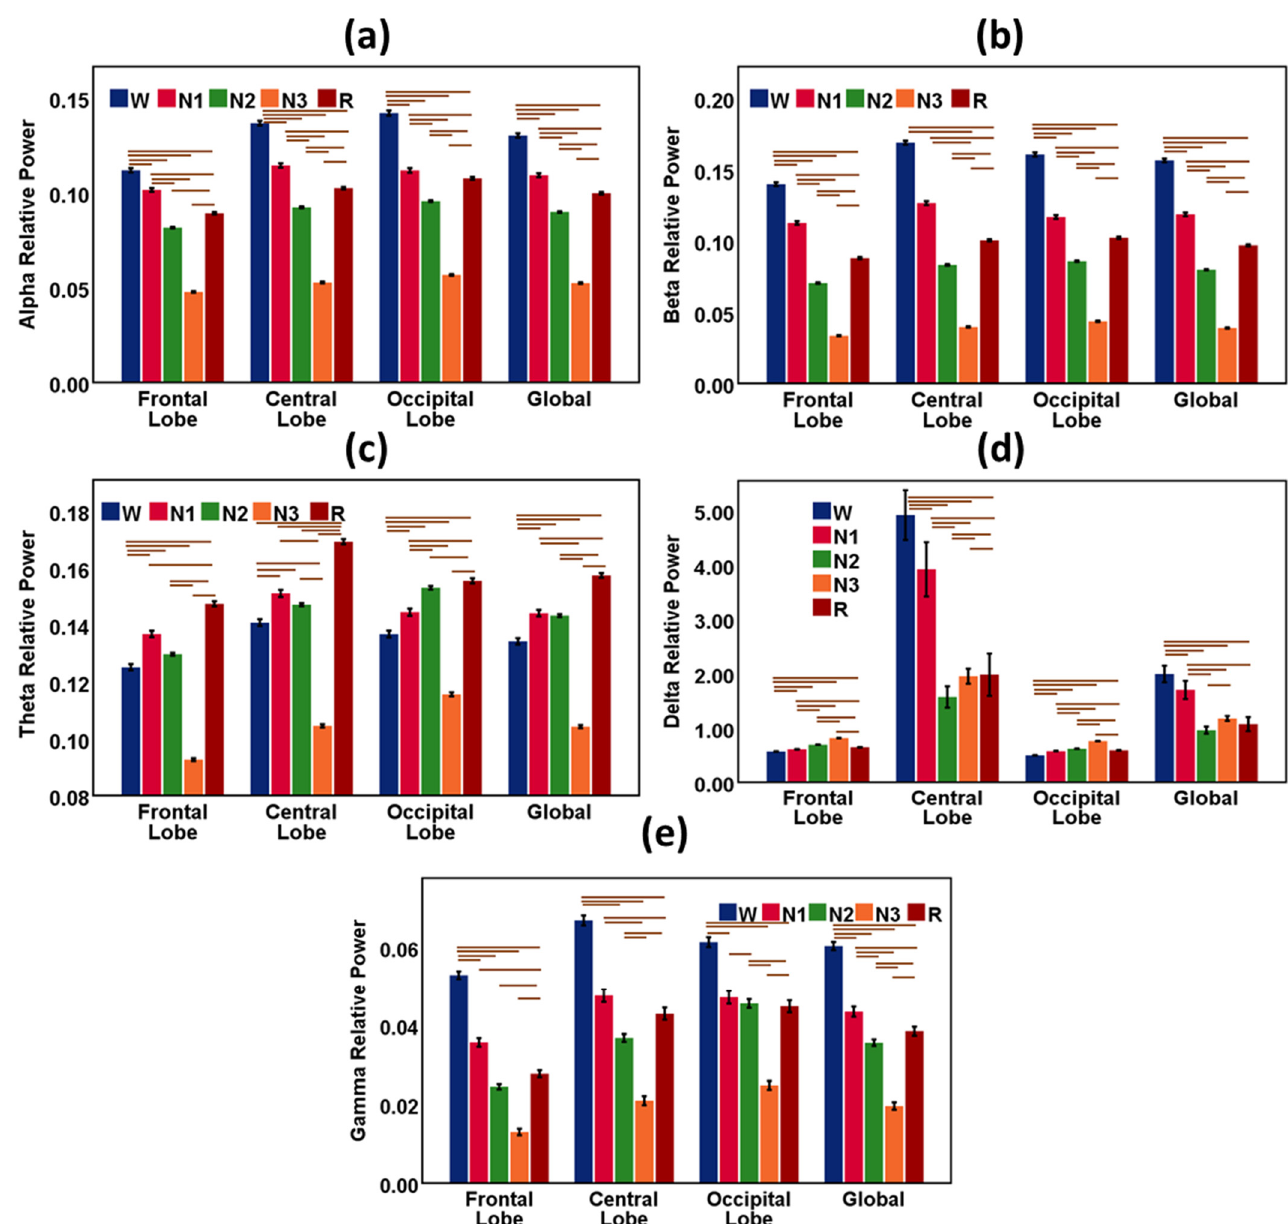
Figure 2. Results from EEG spectral power features during sleep stages W, N1, N2, N-3, and R. The bar chart describes the relative mean power of the EEG waves, and the vertical error bar (black color) is the 95% CI. ( a ) Alpha relative power for sleep stages in the frontal lobe, central lobe, occipital lobe, and global. ( b ) Beta relative power for sleep stages in the frontal lobe, central lobe, occipital lobe, and global. ( c ) Theta relative power for sleep stages in the frontal lobe, central lobe, occipital lobe, and global. ( d ) Delta relative power for sleep stages in the frontal lobe, central lobe, occipital lobe, and global. ( e ) Gamma relative power for sleep stages in the frontal lobe, central lobe, occipital lobe, and global. Global indicates the average measures of features of the frontal, central, and occipital lobes. The horizontal bars (brown color) are the outcomes of the hypothesis tests and indicate significant differences (p < 0.05) in EEG features among the sleep stages.